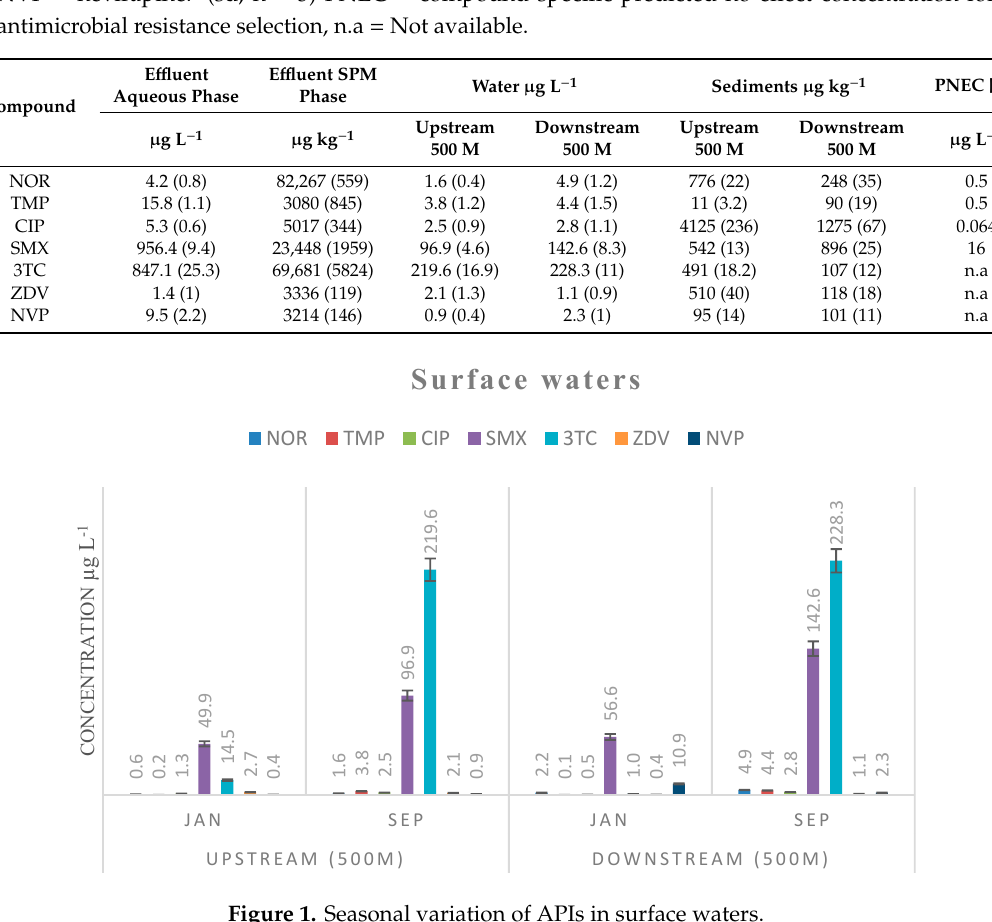
Table 4. Prevalence of antibiotics and antiretroviral cocktails in e ffl uent, SPM, surface water and river sediments in the September sampling. SPM = suspended particulate matter, SMX = Sulfamethoxazole,